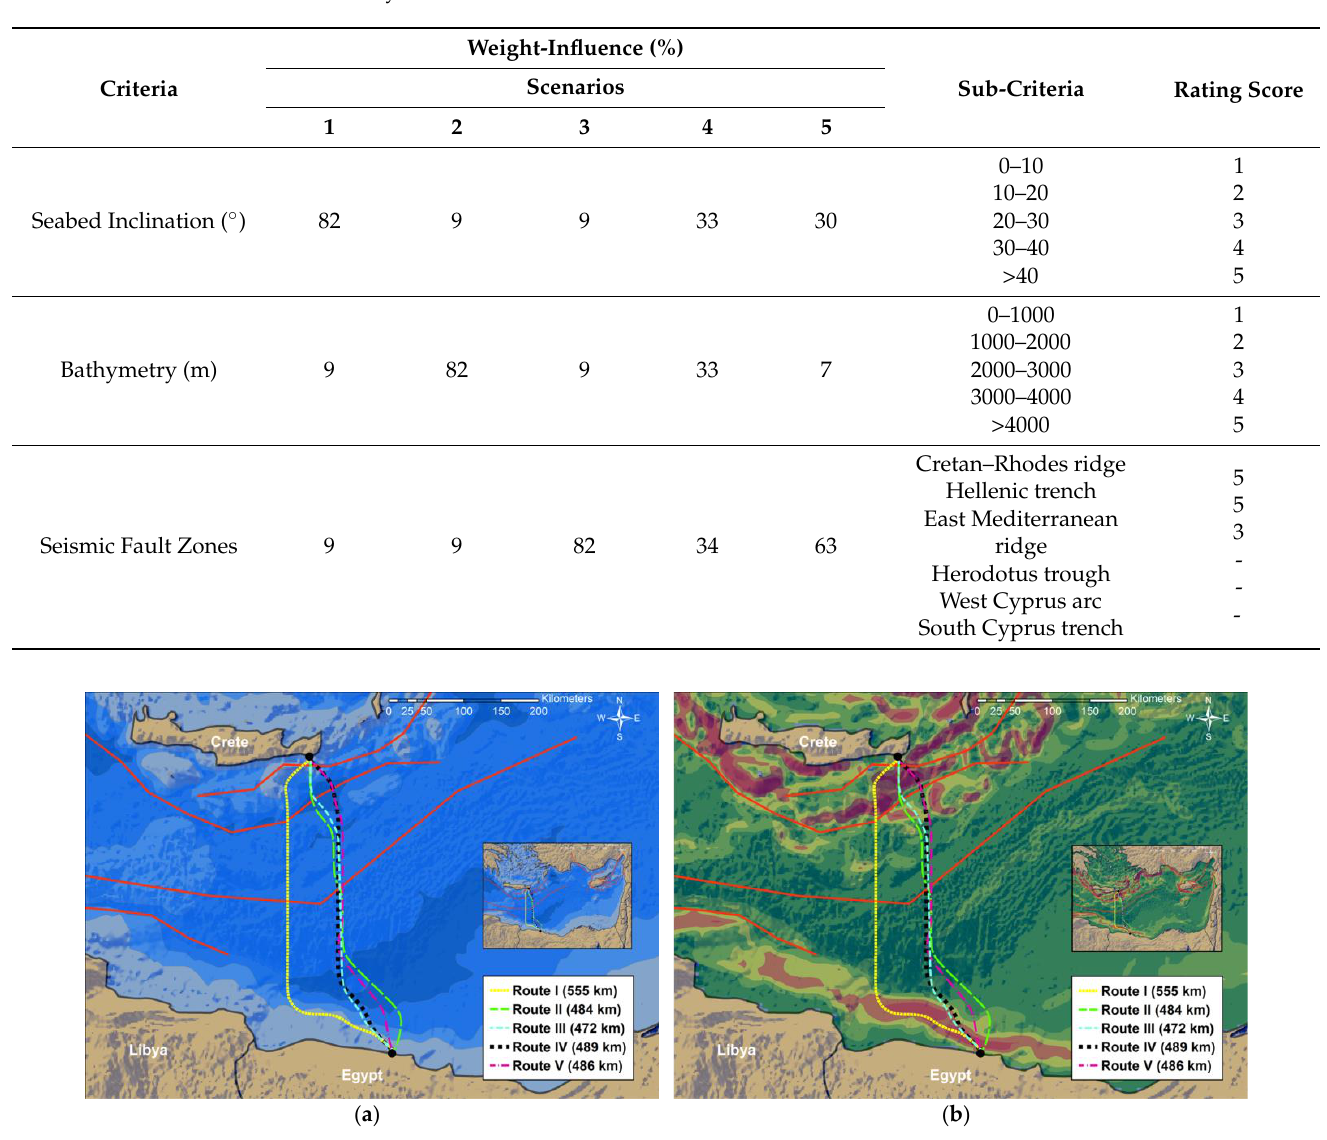
Figure 13. Proposed alternative routes and seismically active fault zones: ( a ) with the bathymetry as a background and ( b ) with the seabed inclination as a background.